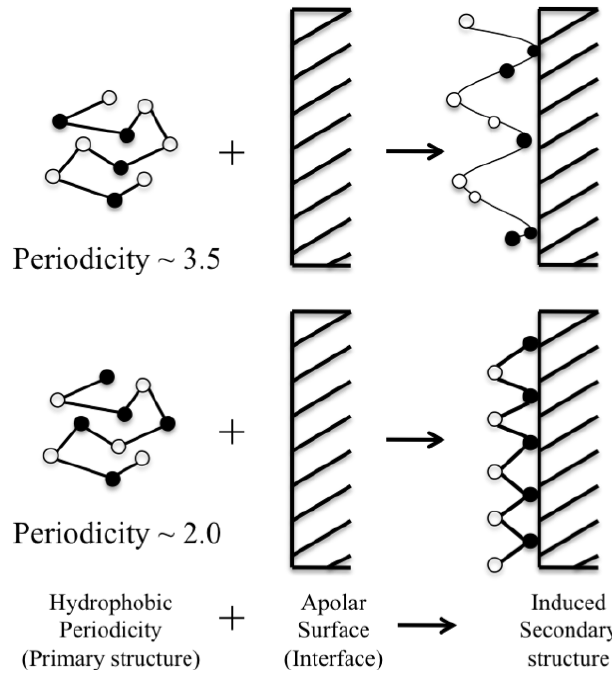
Figure 3. Schematic diagram showing the effect of hydrophobic periodicity on the secondary structure at interfaces. Filled circles are hydrophobic residues and blank circles are hydrophilic residues. Peptides at apolar/water interface arrange in such a way that will maximize the contact between hydrophobic residues and apolar surface and the contact between hydrophilic surface and aqueous environment (adapted from DeGrado et al . [60]).